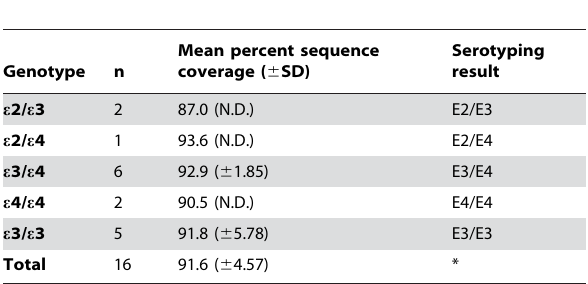
Table 1. Comparison of APOE genotypes with results of APOE protein resequencing and serotyping.